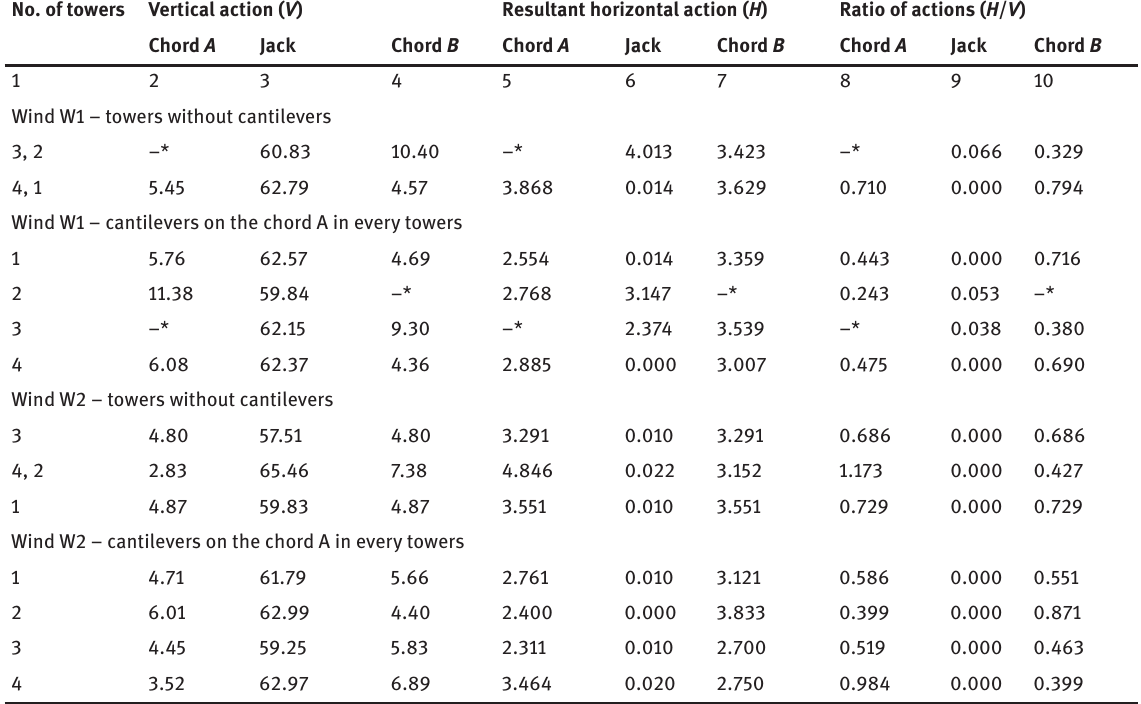
Table 1: Actions of the towers (kN) based on pinned supports. No. of towers Vertical action ( V )